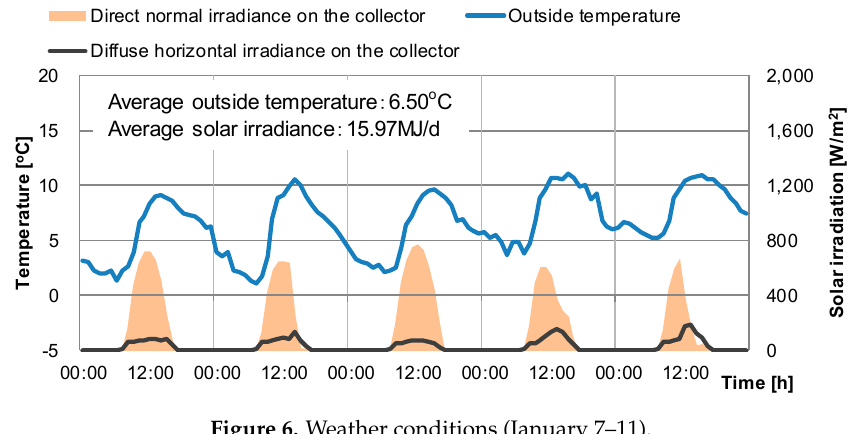
Figure 6. Weather conditions (January 7–11).